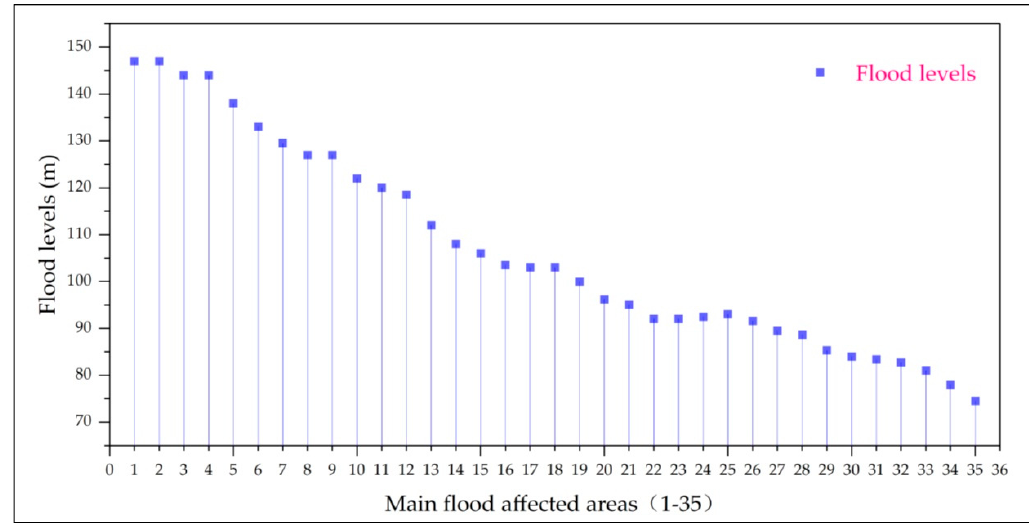
Figure 2. Flood levels of the main affected areas.